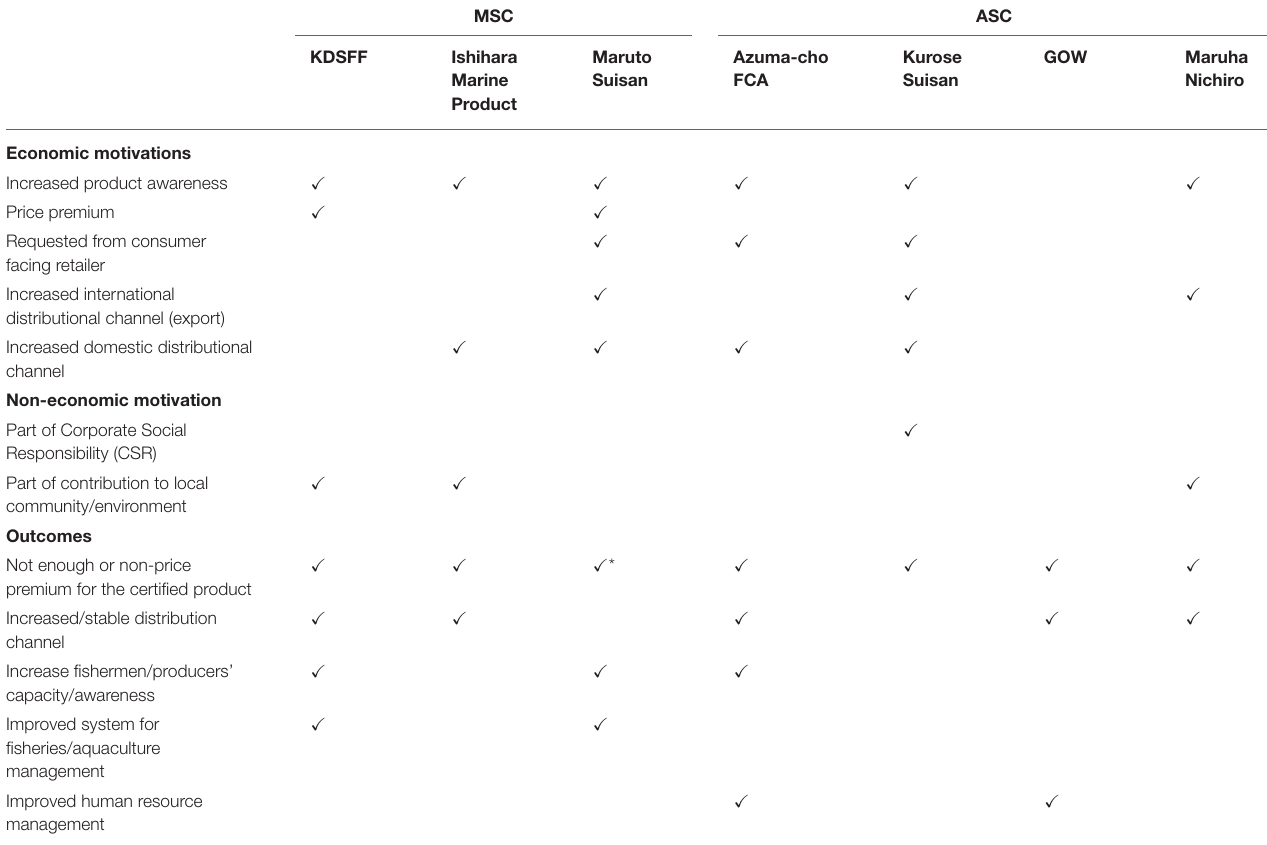
TABLE 4 | Results of coding the semi-structured interviews pertaining to motives. MSC